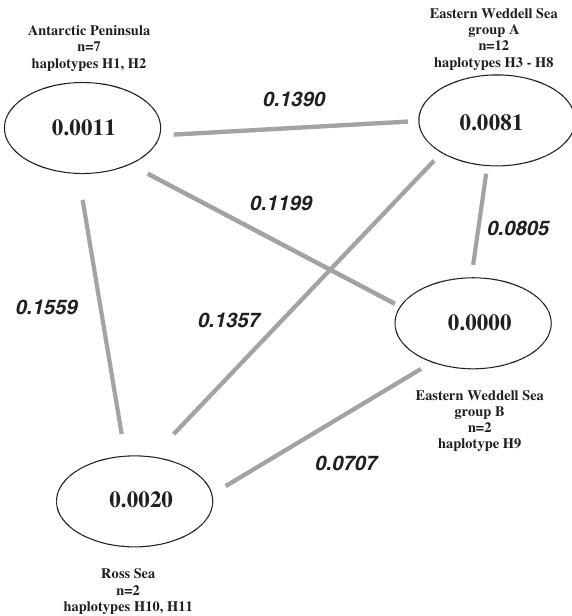
Fig. 3. – Average pairwise genetic distances (HKY + G) within and between four groups of 16S mitochondrial haplotypes of nominate Glyptonotus antarcticus ; n denotes the number of sequences in the group, Hx indicates unique haplotypes as listed in Table